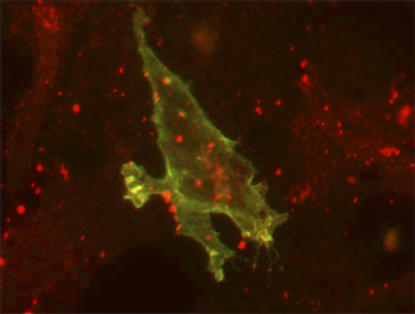
Localization of ephrin-B1 (green) and connexin43 (red) in 3T3 cells.